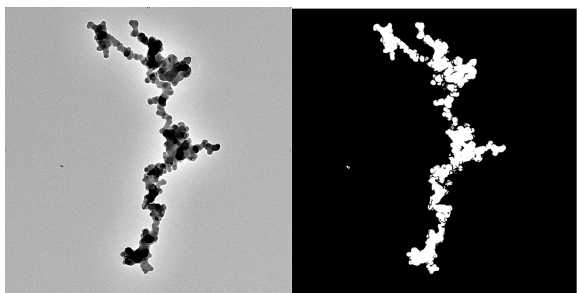
Figure 1. A TEM image of filter samples before ( left ) and after ( right ) being altered in ImageJ .